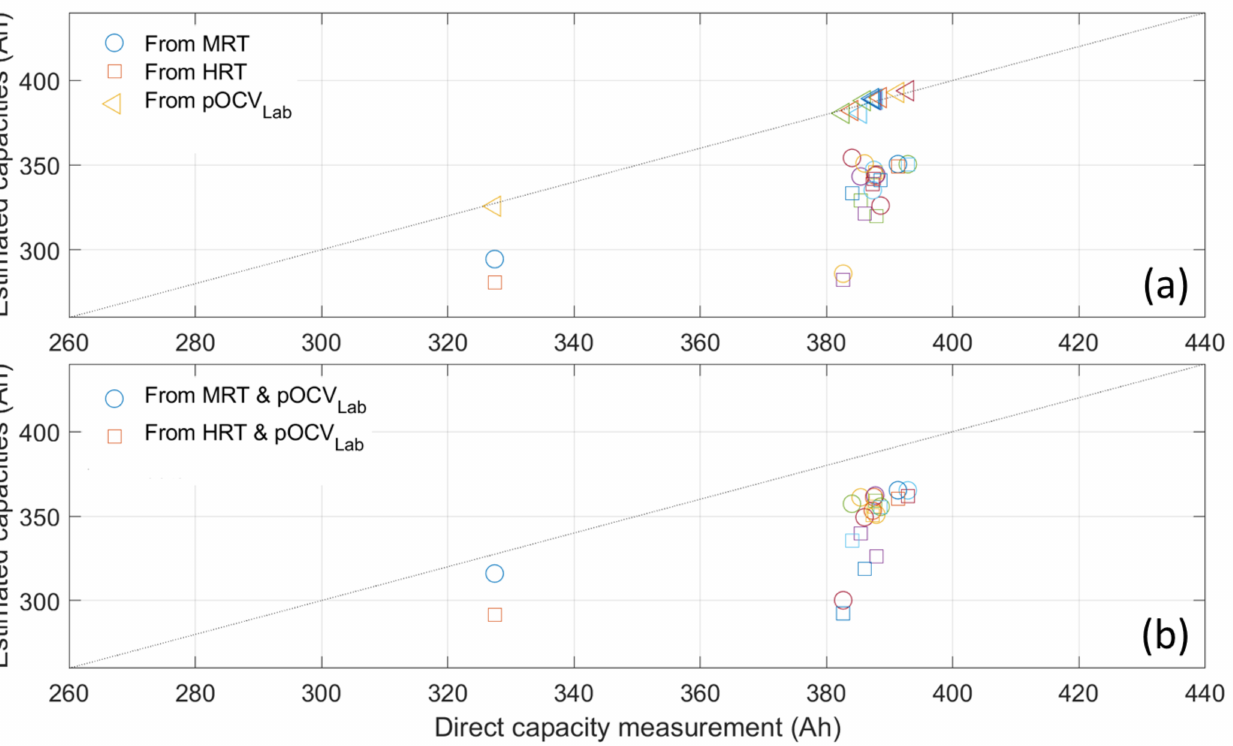
Figure 14. ( a ) comparison of the measured capacity and the estimated ones from the BESS MRT and HRT test and from the laboratory test OCV curves. ( b ) comparison of the measured capacity and the estimated ones from the BESS MRT and HRT tests using each module true OCV